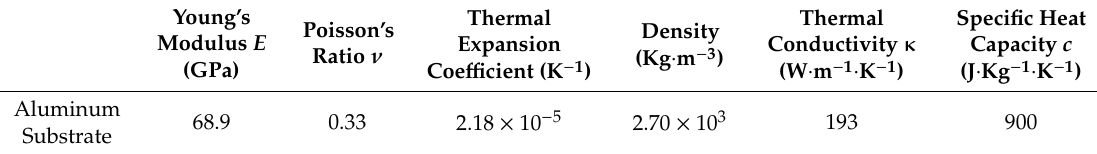
Table 1. Aluminum matrix material parameters.